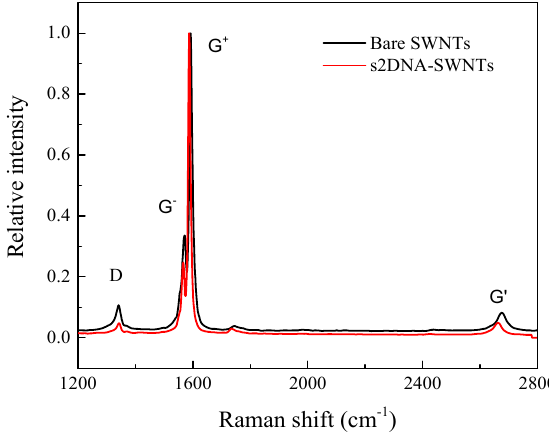
Figure 3. Raman spectra for bare SWNTs (blank) and s2DNA-wrapped SWNTs.